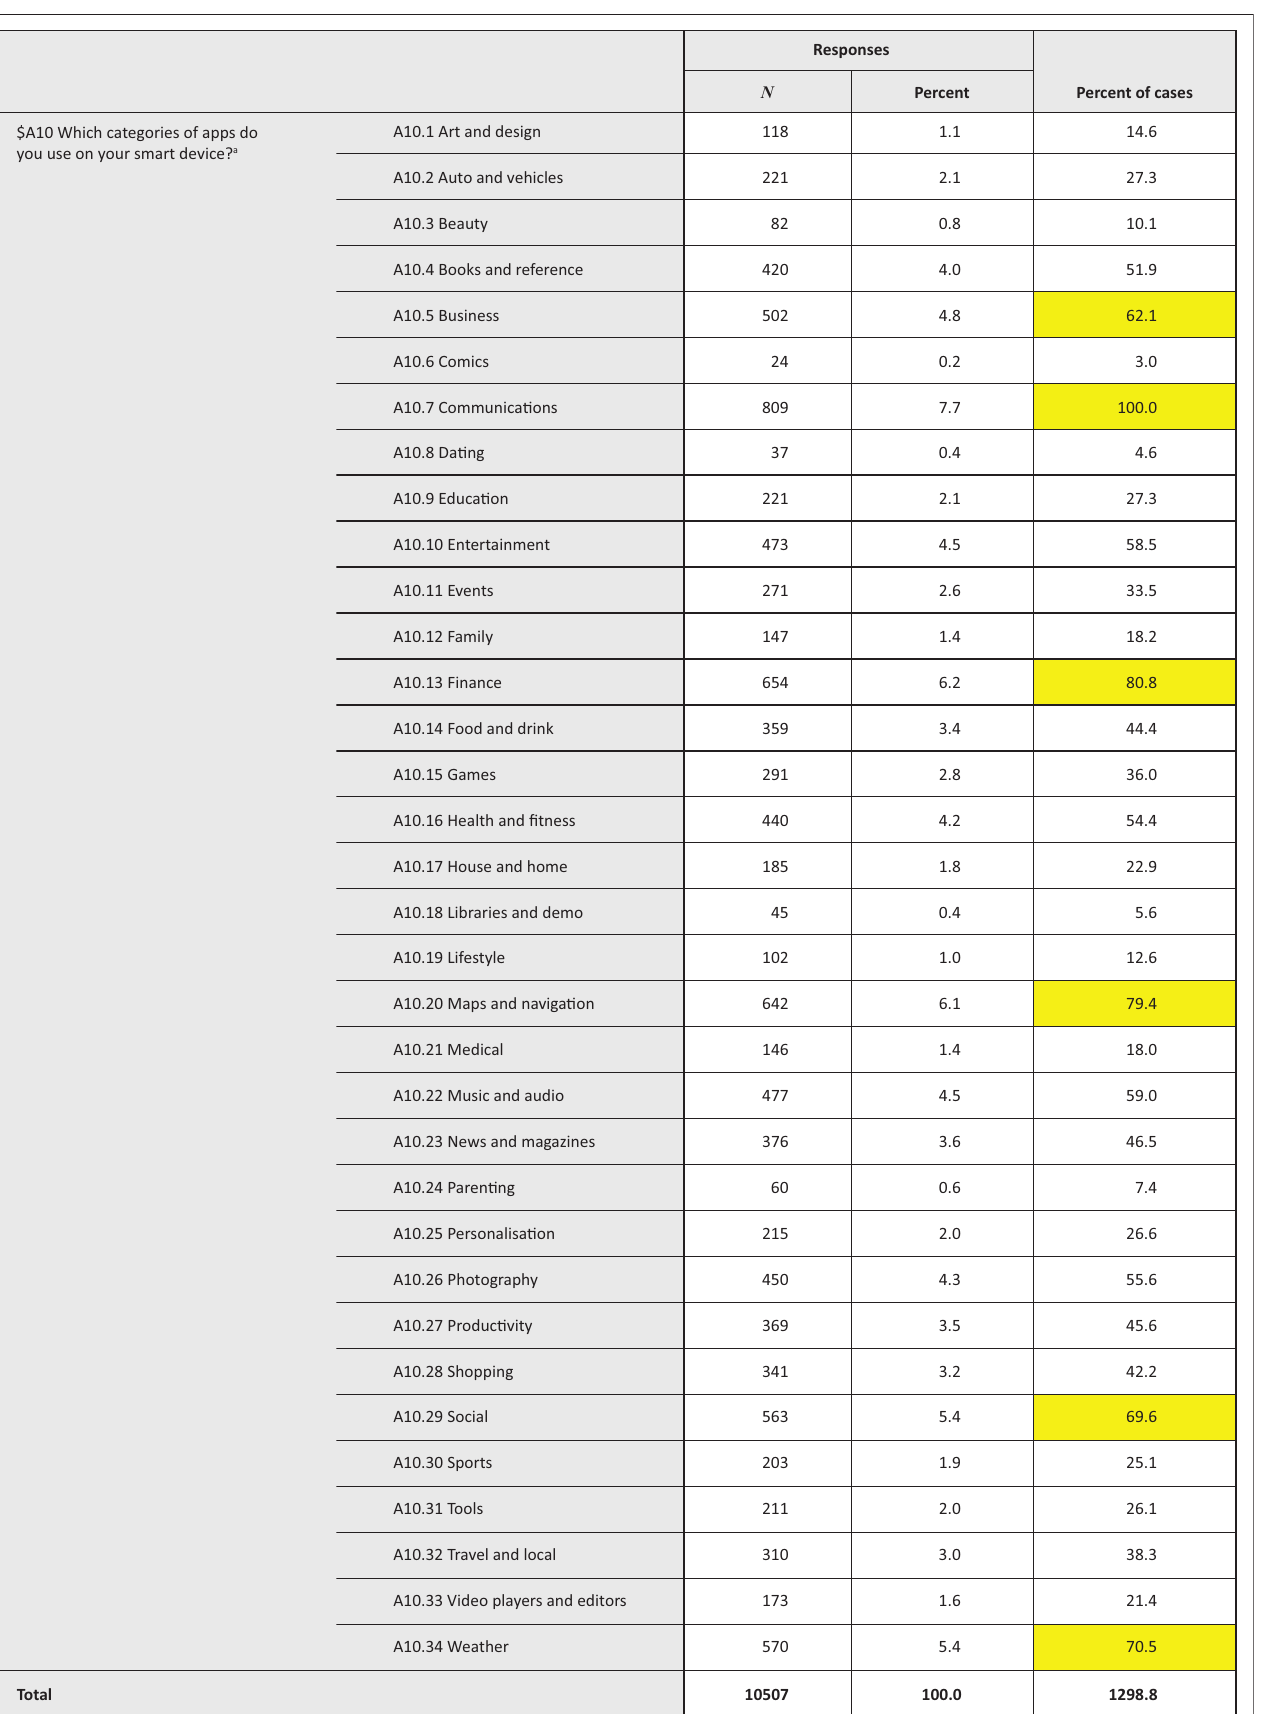
FIGURE 4: App categories used by